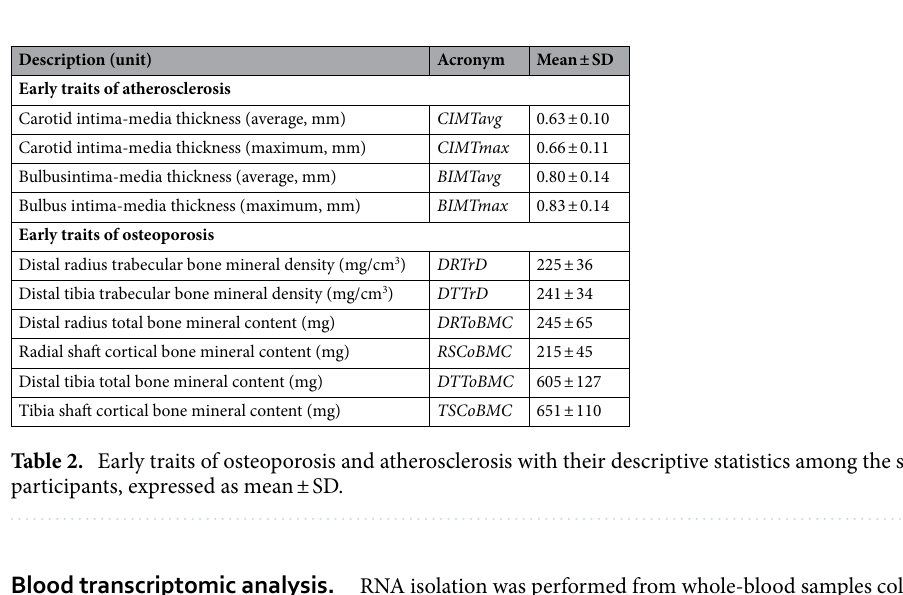
using a nonparametric background correction, followed by quantile normalization with control and expression probes, with the neqc function in the limma package 18 and a log2 transformation. Nine samples were excluded due to sex mismatch between the recorded sex and predicted sex based on RPS4Y1-2 and XIST mRNA levels on the Y and X chromosomes, respectively. After quality control, expression data was available for 1,654 samples,